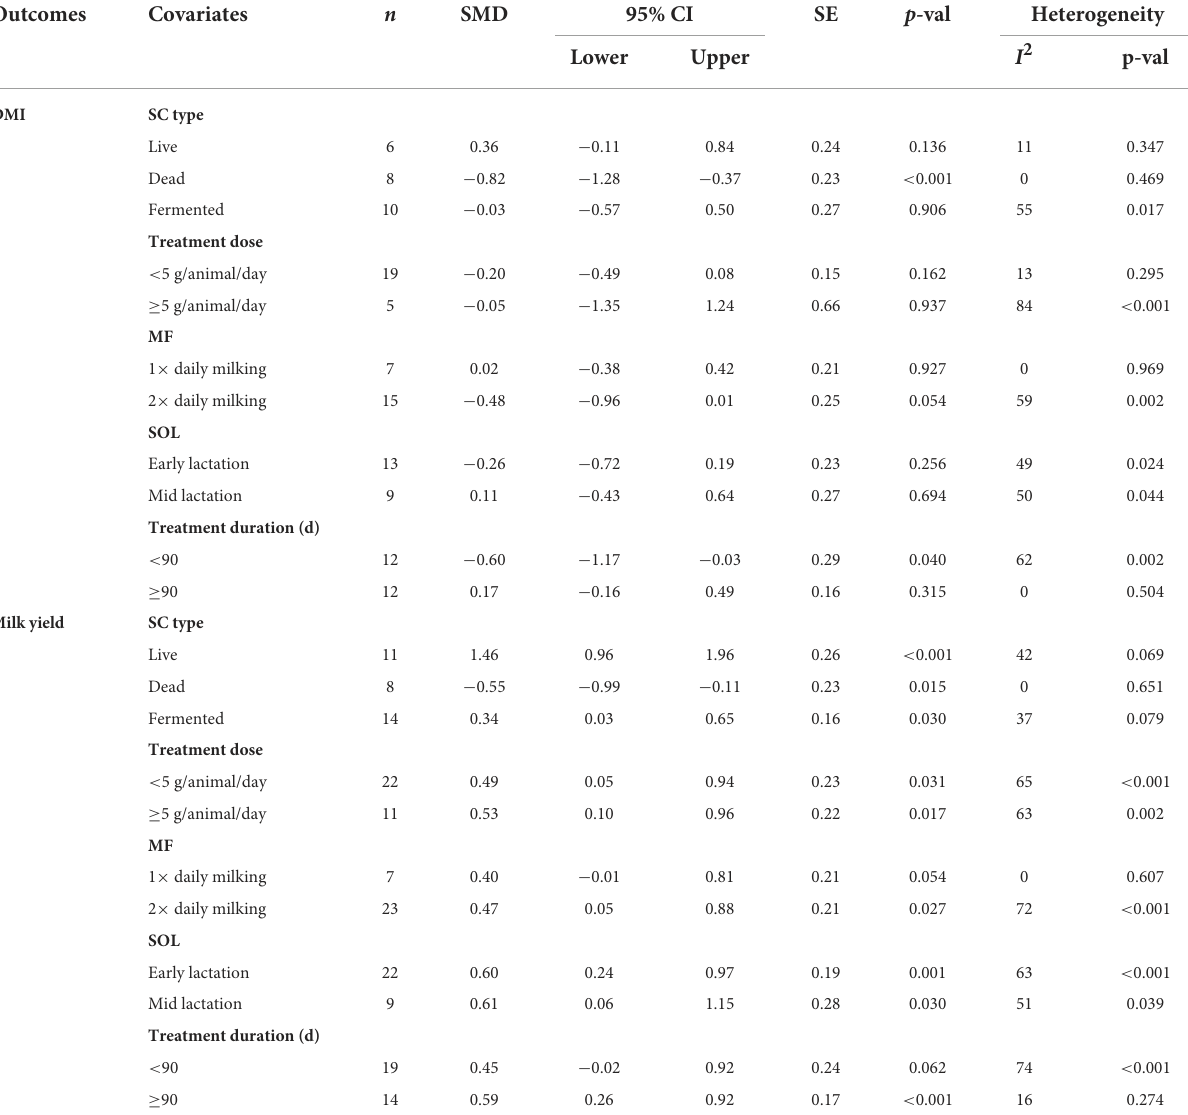
TABLE 3 Effect of covariates on DMI and milk yield of lactating goats fed SC supplemented diets. Outcomes